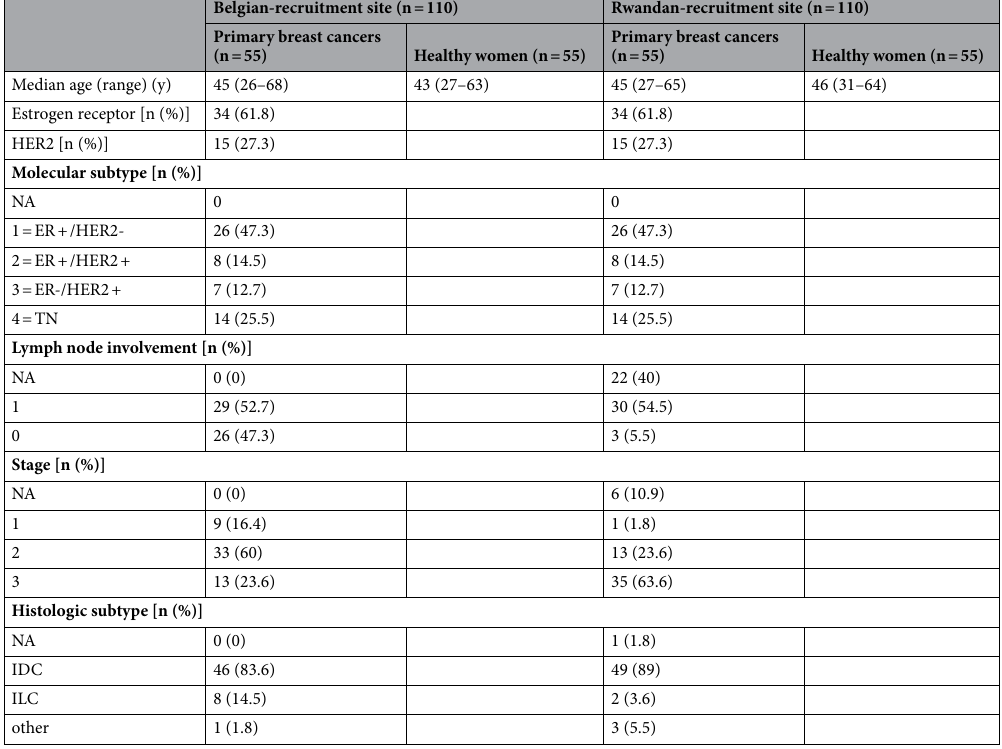
Table 1. Matched cohorts – Clinical and pathological data and tumor characteristics of study